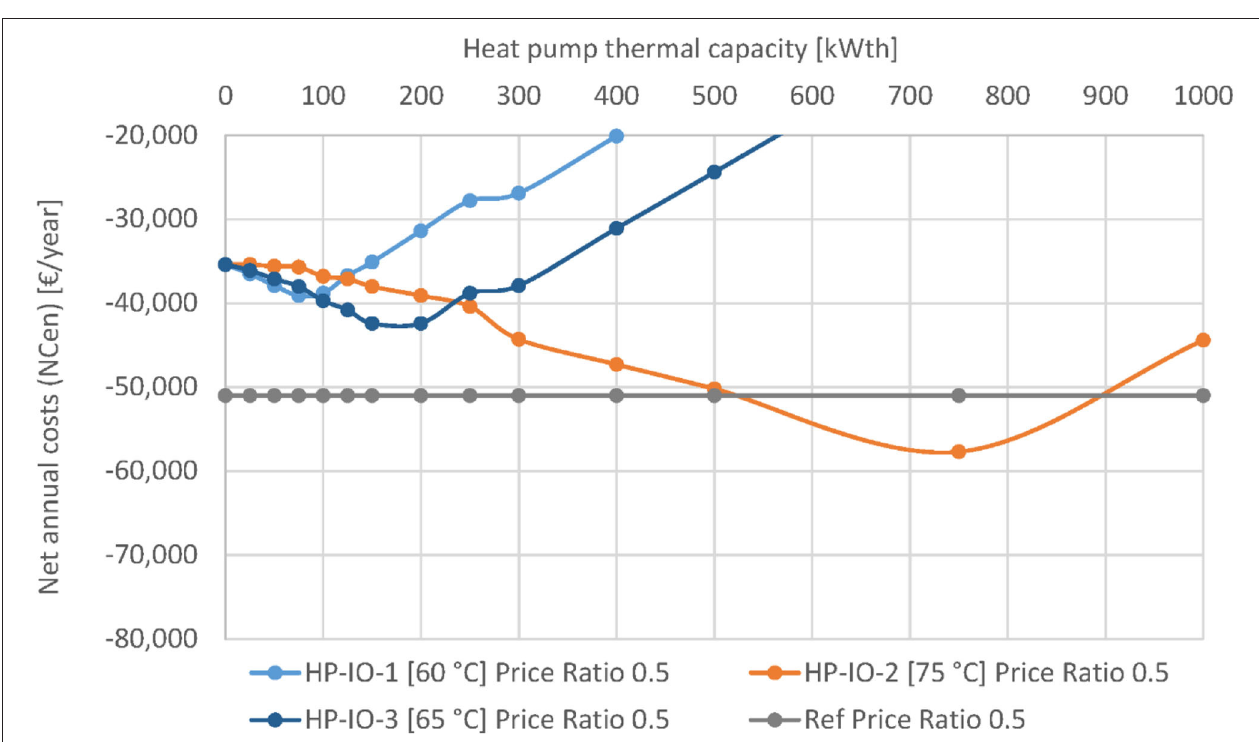
FIGURE 6 | Net annual costs ( NC En ) of three heat pump integration options at price ratio 0.5. Negative net annual costs are net annual savings.